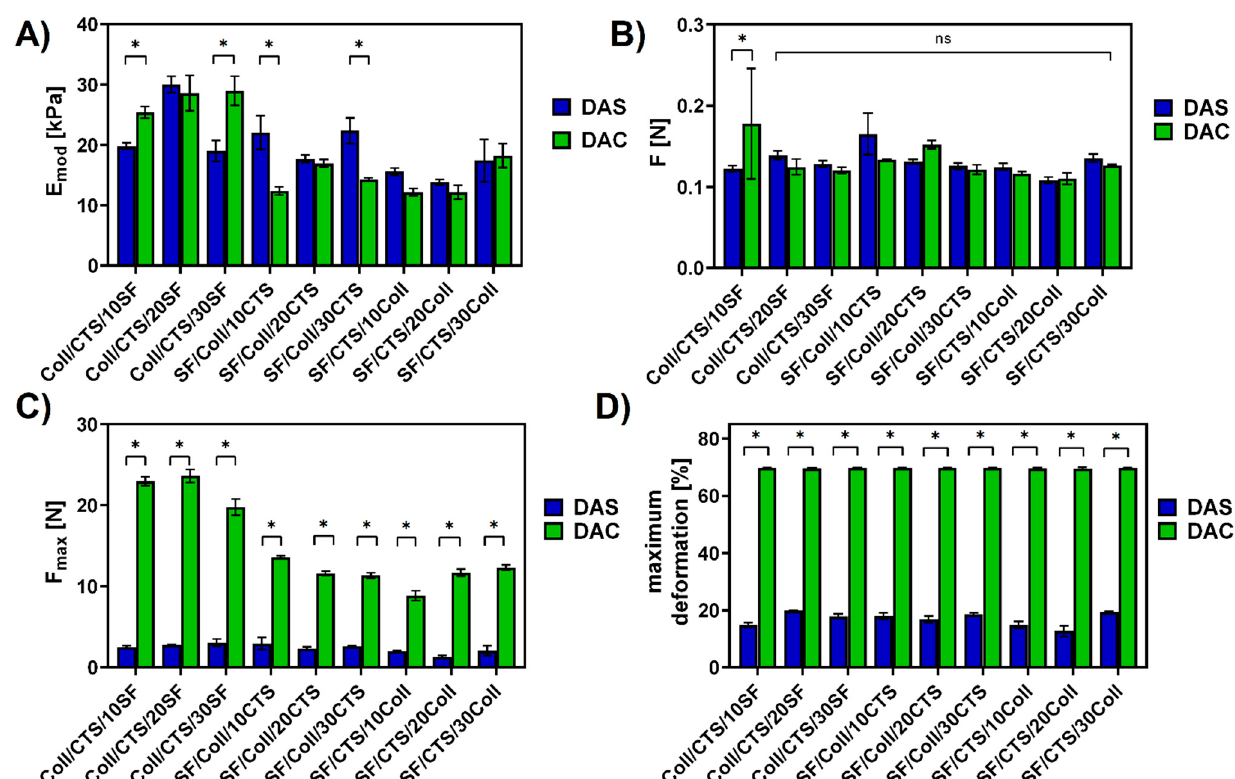
Figure 11. Mechanical parameters of the scaffolds cross-linked with dialdehyde starch (DAS) and dialdehyde chitosan (DAC): ( A ) Young’s modulus (E mod ); ( B ) force at maximum deformation (F); ( C ) maximum force (F max ); ( D ) maximum deformation. Results are presented as mean ± standard error of the mean (* p ≤ 0.05 between cross-linkers; ns: no significant difference according to one-way ANOVA with Holm–Sidak post hoc test, GraphPad Prism 8.0.1.244).